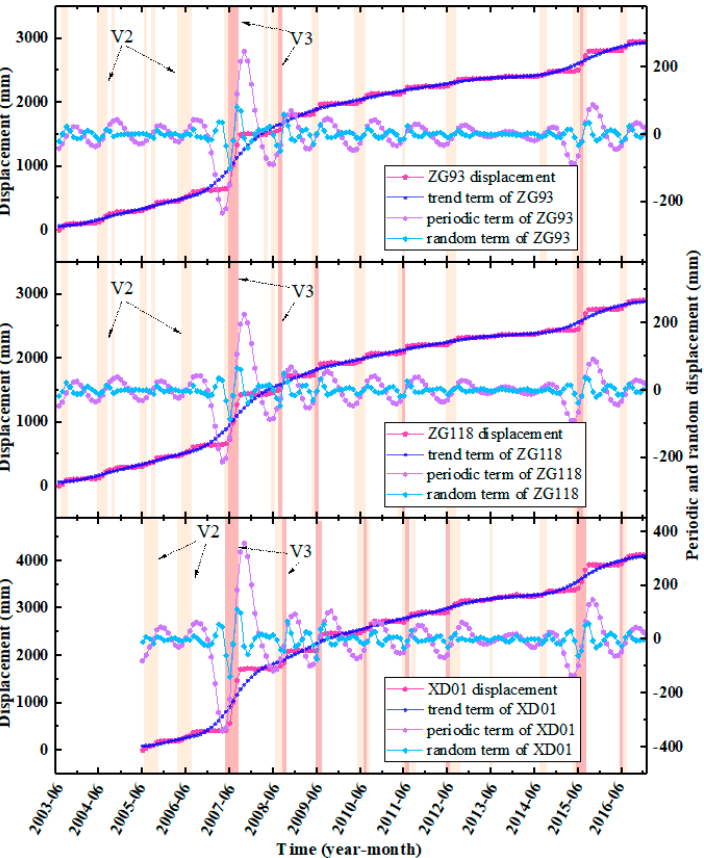
Figure 11. VMD decomposition of displacements at the monitoring points (ZG93, ZG118, XD01).